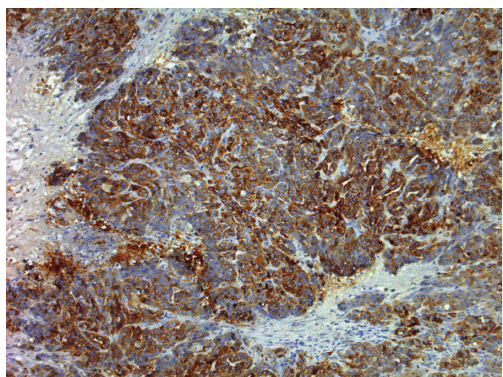
Figure 3: Solid carcinoma. Aberrant P-cadherin immunoreac- tivity in luminal epithelial cells (membranous and cytoplasmic) (streptavidin-biotin-peroxidase method,